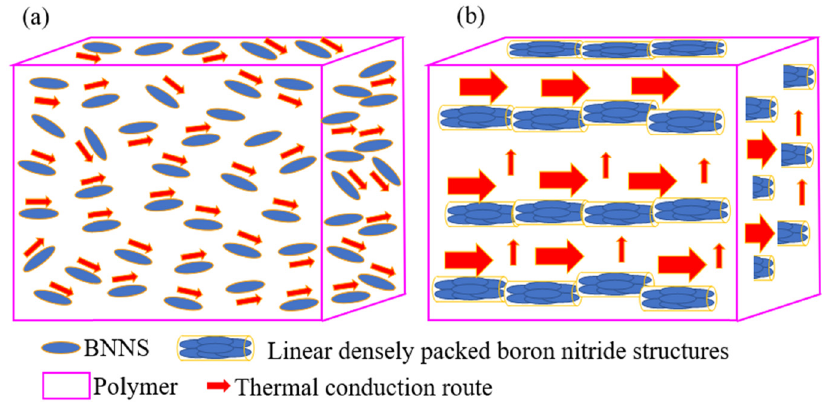
Figure 6: Schematic illustrations of thermal conduction routes in polymer composites reinforced by ( a ) randomly distributed BNNS and ( b ) oriented linear densely packed BN structure. The larger arrows indicate that the thermal conduction is more e ffi cient than that of the smaller